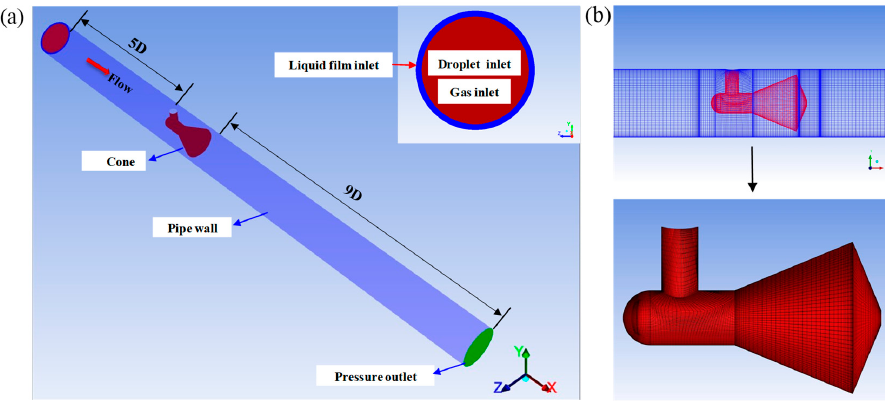
Figure 5. Geometry model and grid ( β = 0.55) ( a ) geometry structure; ( b ) grid.